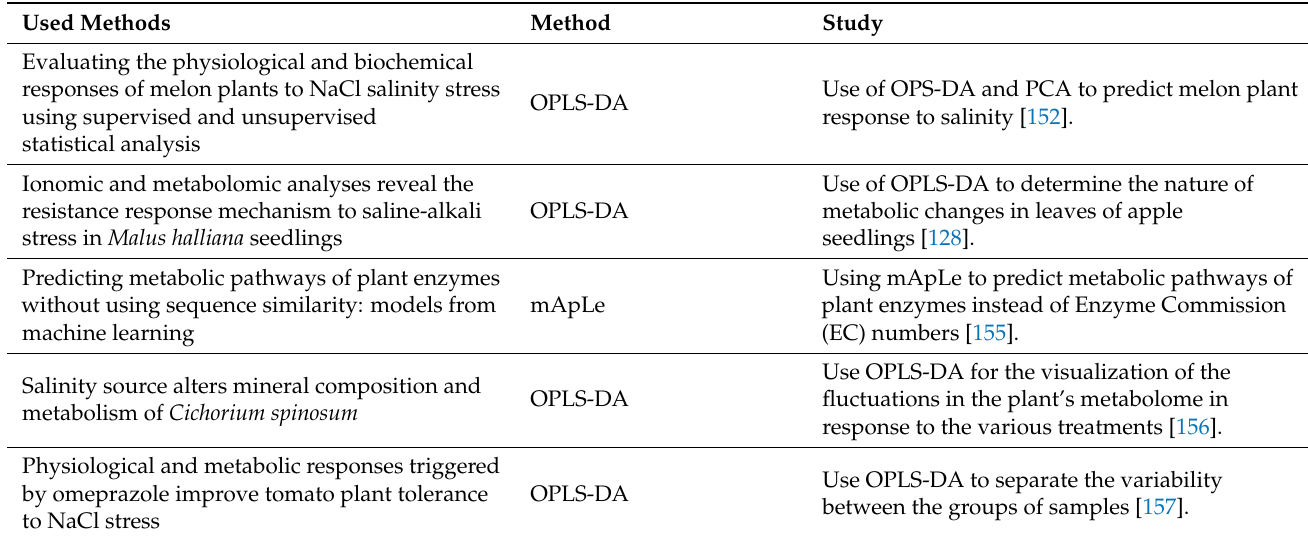
Table 2. Examples of data science in plant metabolomic scientific